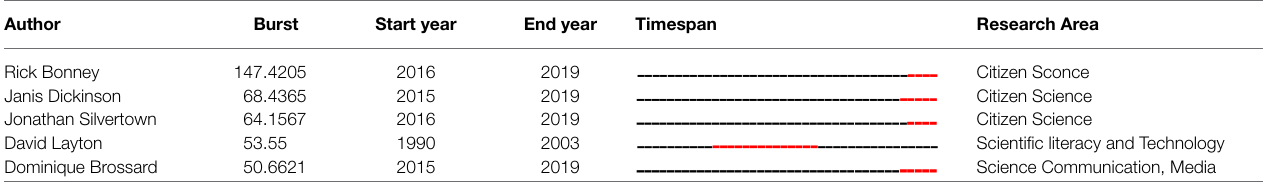
TABLE 4 | Authors with highest burst count in the intellectual structure of scientific literacy between the years 1980 to 2019.